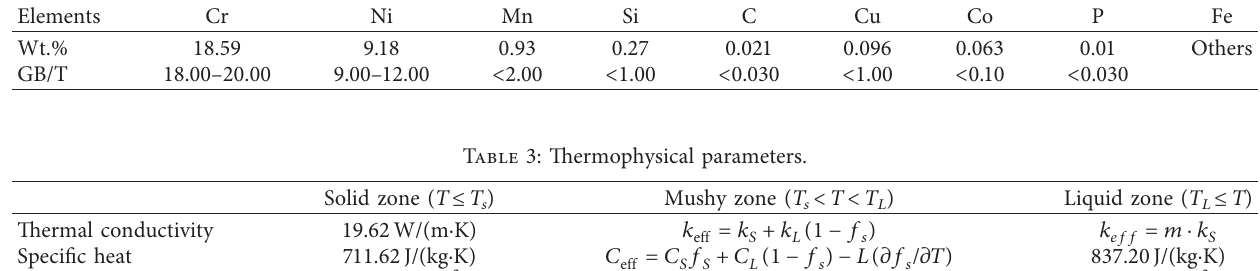
Table 2: Chemical composition of nuclear power stainless steel.